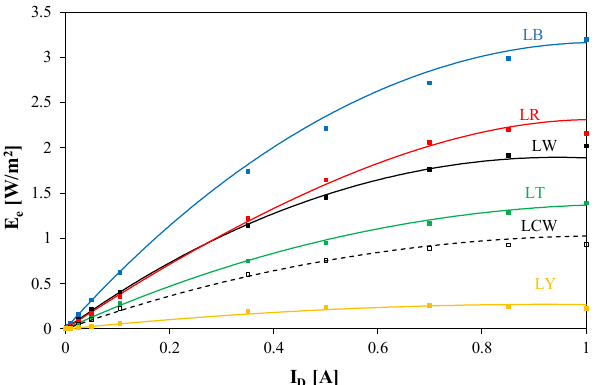
Figure 6. Computed and measured dependence of the surface power density E e on forward cur- rent.